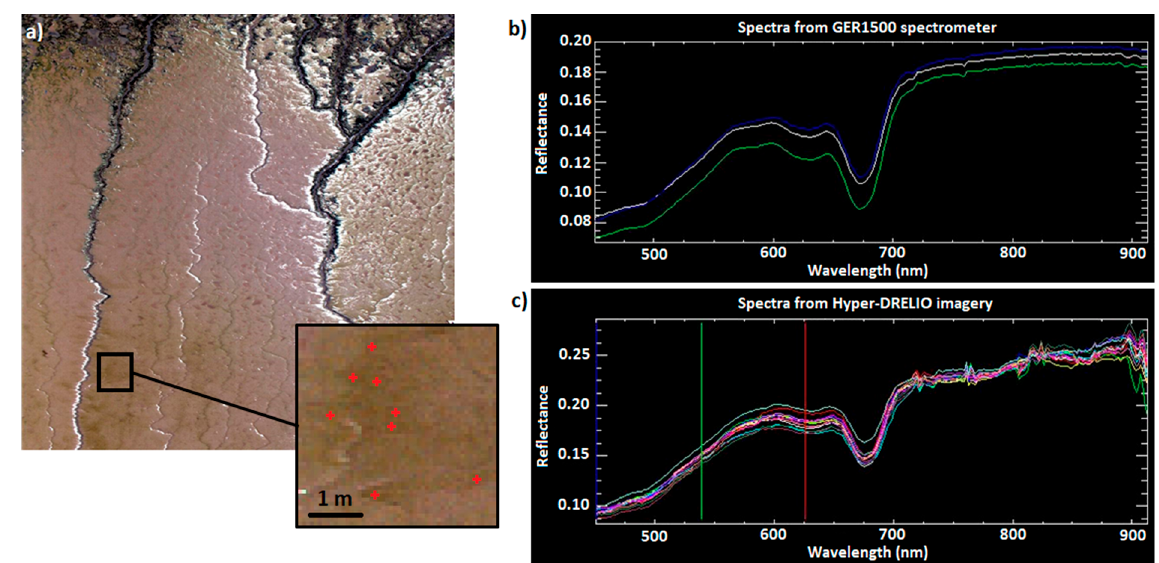
Figure 6. Spectra comparison above the benthic biofilm. ( a ) Biofilm patch on the Hyper-DRELIO image (in natural colours) where the spectra are pointed (red crosses). The image was acquired on 2018-09-12 at 13:15. ( b ) Biofilm spectra measured by GER1500 spectrometer. ( c ) Biofilm spectra extracted from Hyper-DRELIO imagery (mean standard deviation between the reflectance spectra: 0.004).